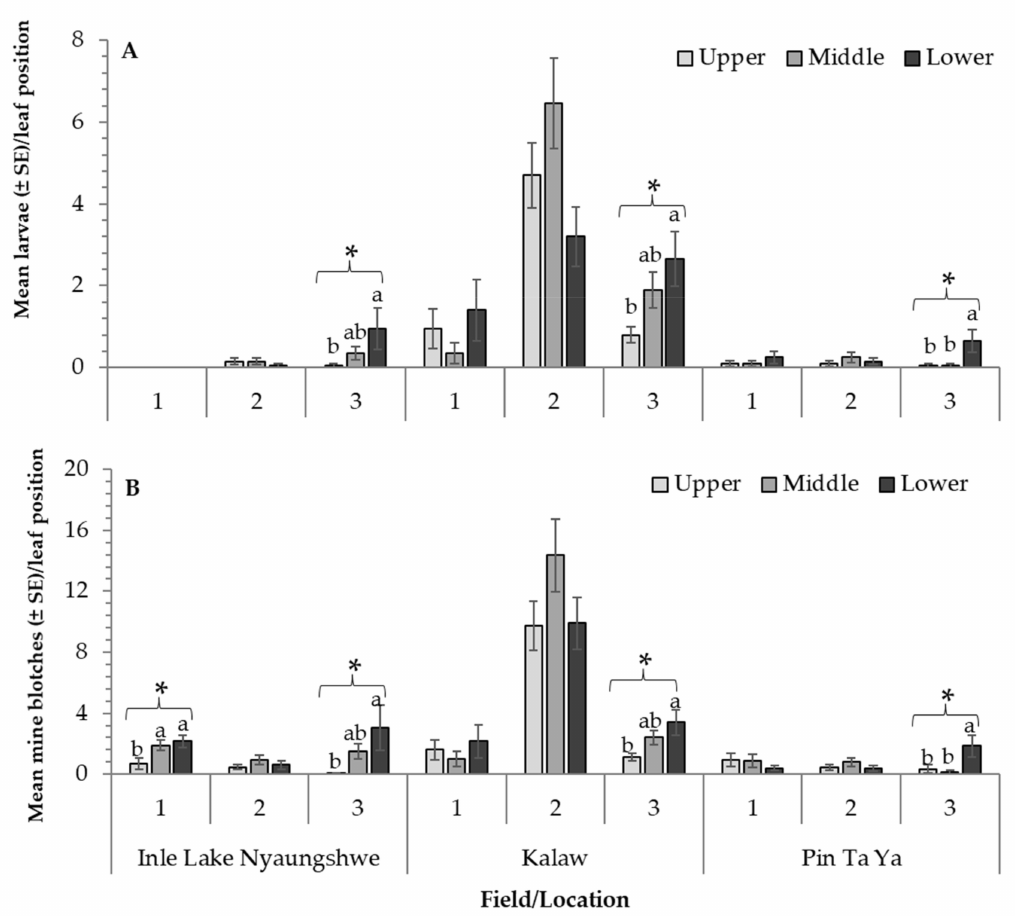
Figure 3. ( A ) Mean Tuta absoluta larvae and ( B ) mine blotches found on upper, middle and lower strata recorded in three locations and two tomato cultivation methods in Myanmar. * Statistical values provided for the locations where Tuta absoluta larvae and mine blotches differed among leaf position. Bars with the same letter(s) within each field/location are not significantly different ( p < 0.05) (See text for statistical